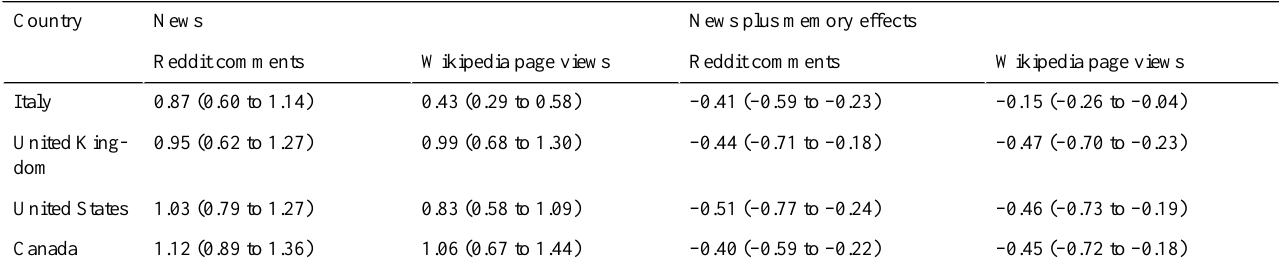
Table 3. Coefficient estimates (95% CI) for Model III (news plus memory effects). All coefficients are significant with P